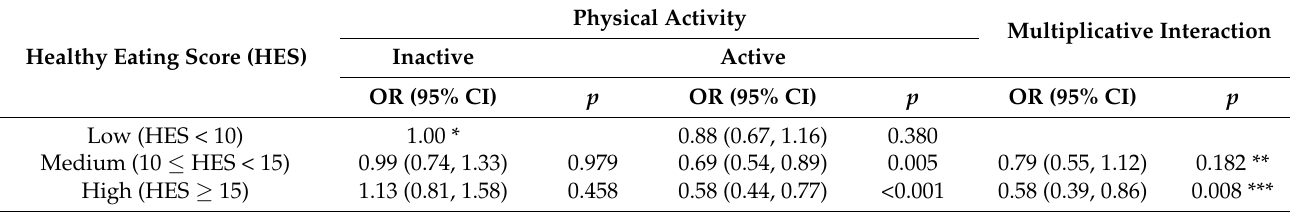
Abbreviations: HES, healthy eating score. ORs are adjusted for age, gender, occupational status, education attainment, medication payment ability, social status, BMI. * The single reference group is “physical inactivity and low HES”. ** The p -value of the interaction term: